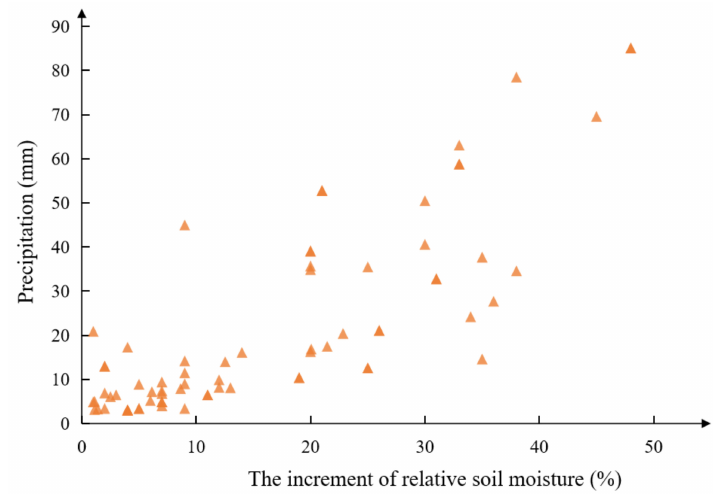
Figure 4. Scatter plot for soil moisture and precipitation